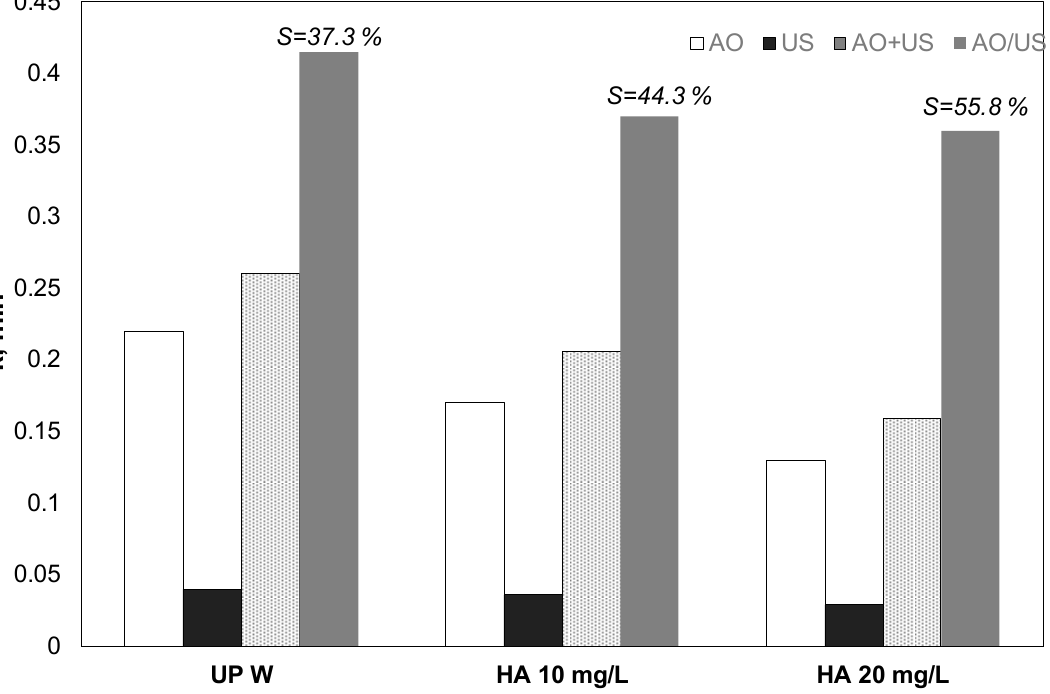
Figure 6. E ff ect of humic acid on the kinetic constant for the removal of 0.5 mg / L propyl paraben by electrochemical anodic oxidation (AO), ultrasound (US), theoretical sum (AO + US) and combined (EO / US) process [Na 2 SO 4 ] = 0.1 M, 3.75 mA / cm 2 , 36 W / L at 20 kHz and inherent pH. UPW: Ultrapure water and 0.1 M Na 2 SO 4 , HA: Humic acid.